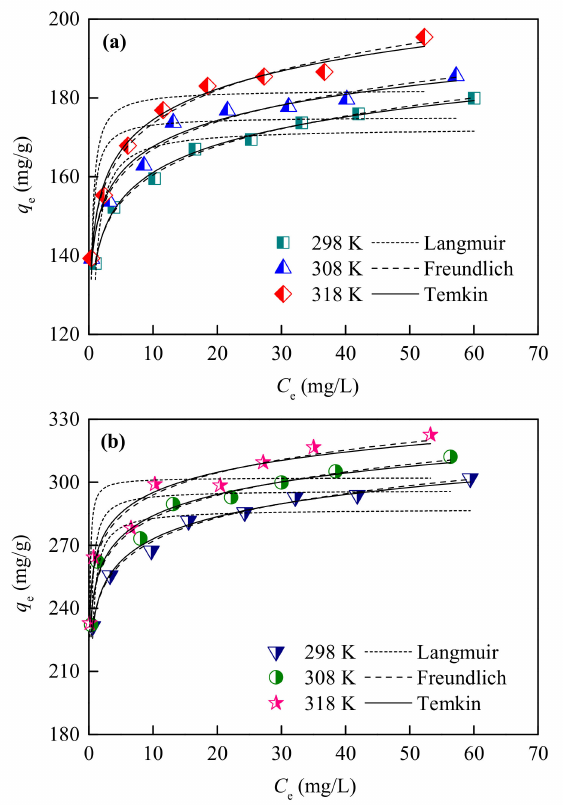
Figure 12. Isothermal adsorption fitting of RSB 600 ( a ) and M-RSB 600 ( b ) for